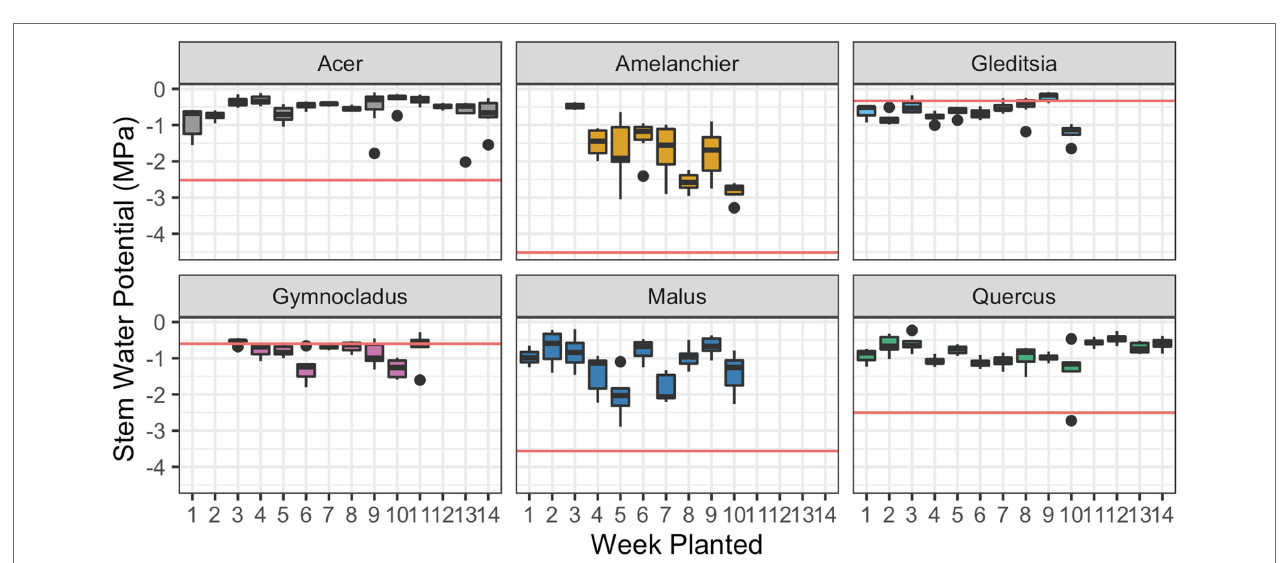
FIGURE 3 | Stem water potential at the time of removal from cold storage and subsequent planting. Box plots show median, interquartile range, and minimum and maximum range for each week of planting. Solid red lines indicate stem P 50 for each species, estimated by the stem vulnerability curves. There was evidence of a significant negative effect of planting date on stem water potential for Amelanchier ( p < 0.01; details in text and Table 3 ). For all other cultivars, there was no evidence of a significant effect of planting date on stem water